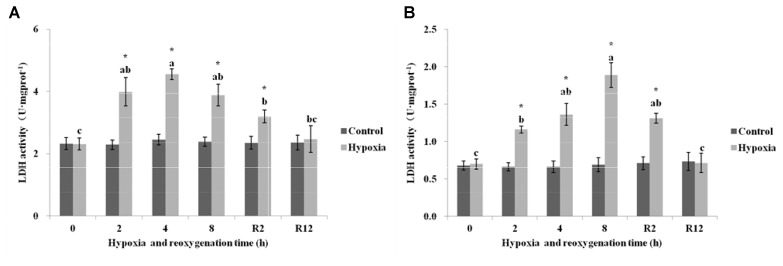
Effect of environmental hypoxia on LDH of E. sinensis
(A) and P. sinensis
(B). There was no significant difference between bars with the same letter (P < 0.05). Asterisk represents a significant difference between control and hypoxia groups at the same time point (P < 0.05).